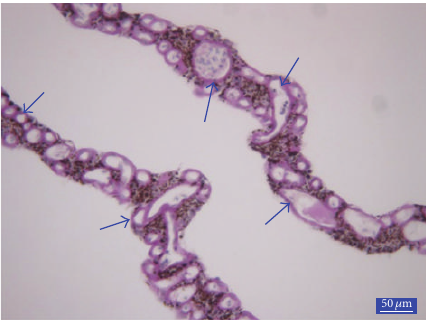
Figure5:Asectionfromtheduckpectenoculi.Arrows:Largeblood vessel and many capillaries having thick basement membrane. PAS, bar 30 𝜇 m.